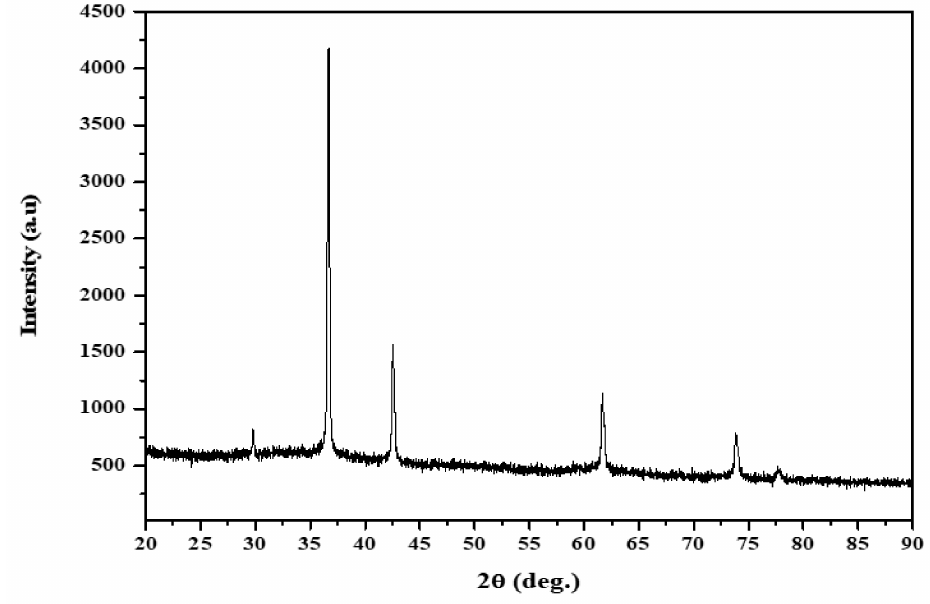
Figure 4. X-ray diffractogram of FeCu